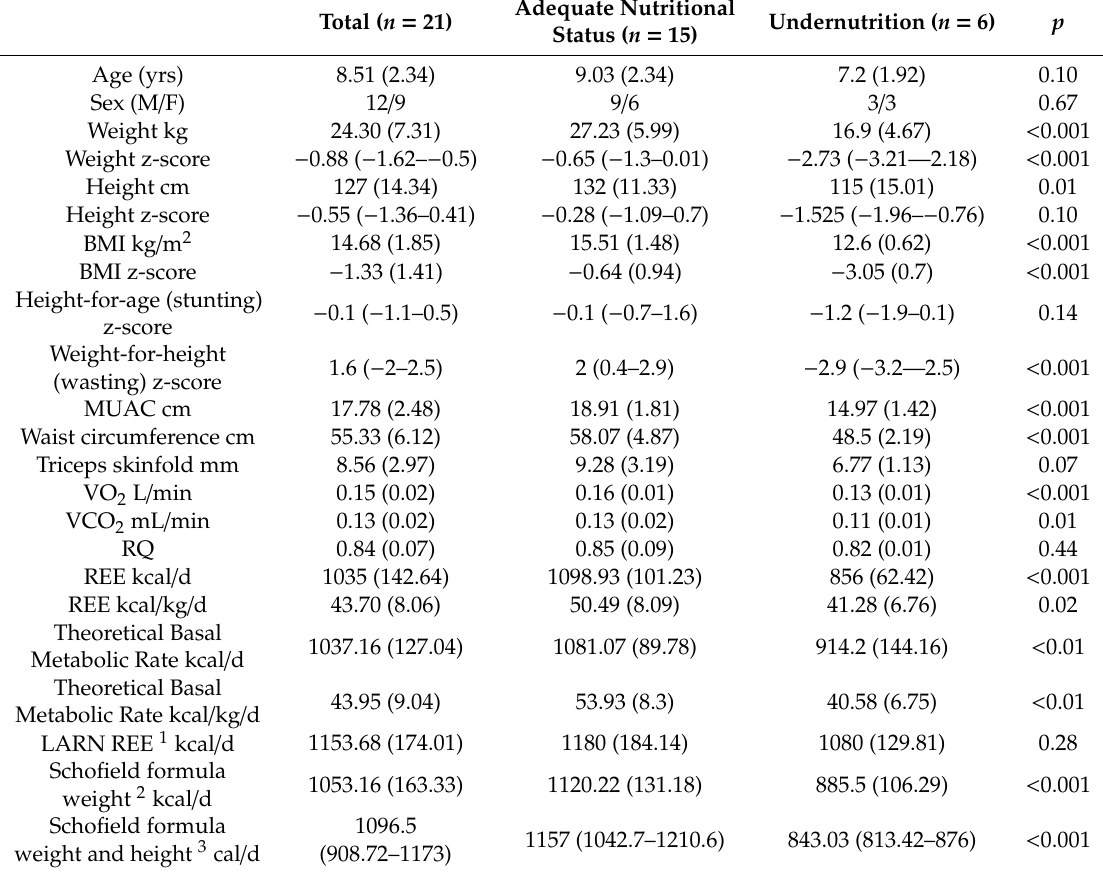
Table 1. Clinical features and energy metabolism of the patients according to nutritional